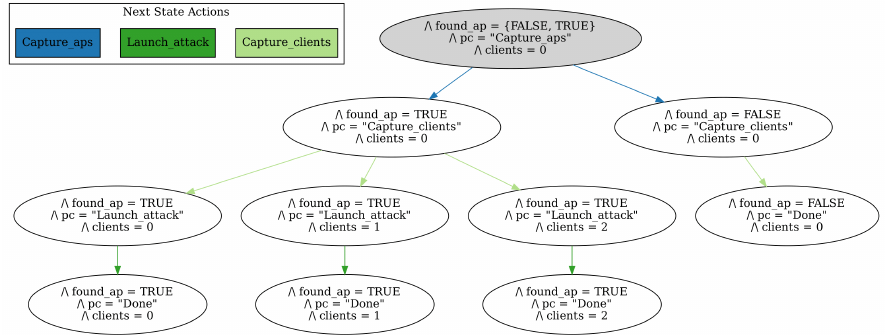
Figure 19. State transition diagram showing all possible states of the DOS attack EP model.